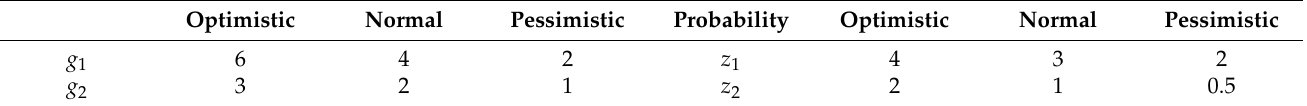
Table 5. Risk probabilities of project synergy values in optimistic, normal, and pessimistic circum-